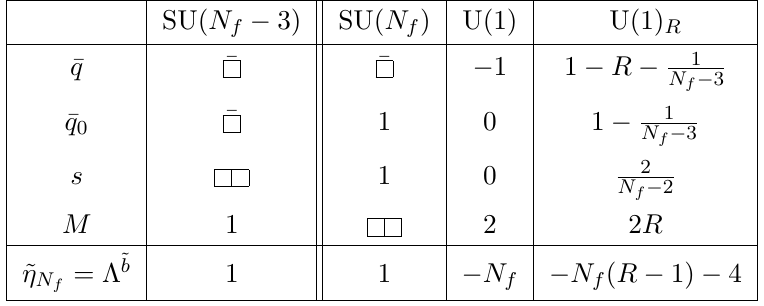
Table 3 . A magnetic dual of the 4d N = 1 G 2 gauge